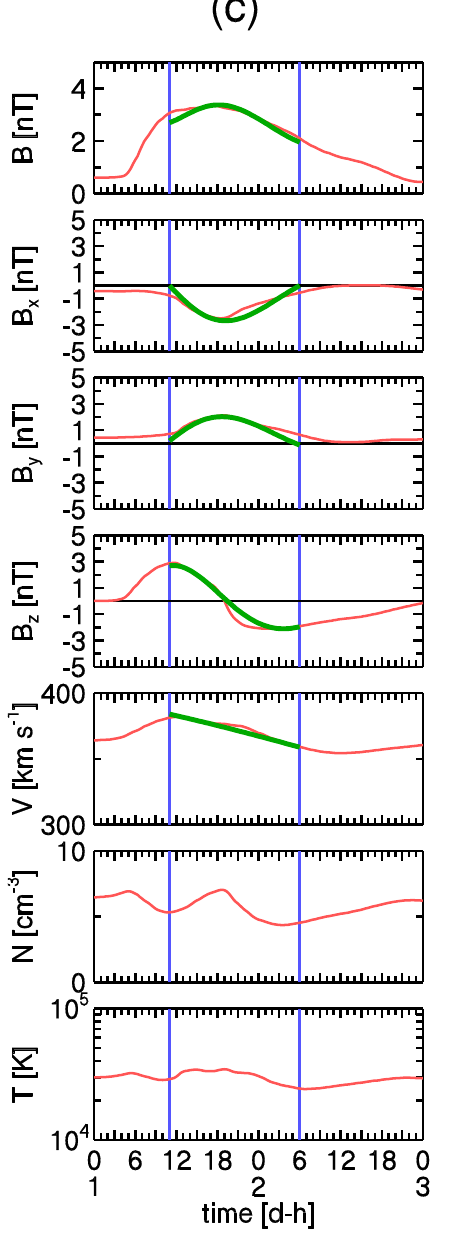
Fig. 5. Simulated time profiles in the point C. The layout is similar to Fig. 2.